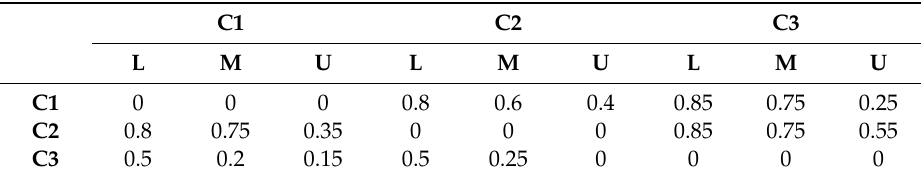
Table 4. Fuzzy direct relation matrix between the main categories.